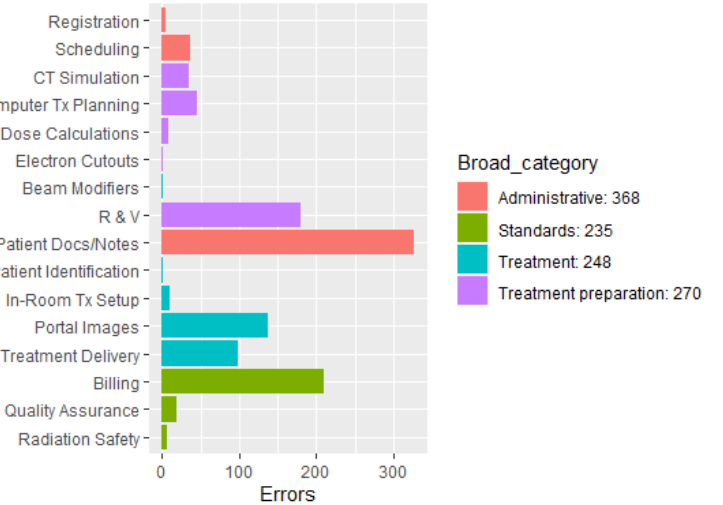
Figure 2. Frequency distribution of the 16 event categories ( left ) and the 4 broad categories ( right